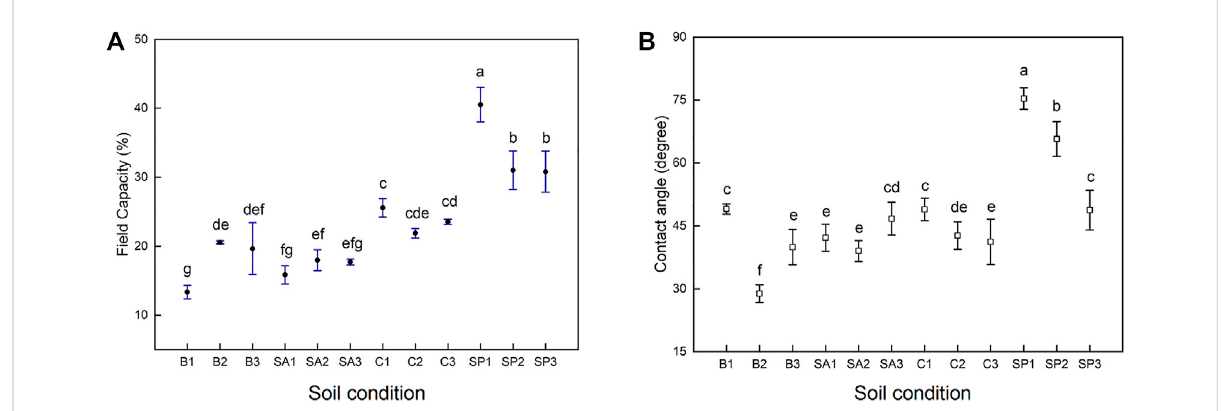
FIGURE 3 The fi eld capacity (A) and contact angle (B) of the soils under different vegetation. The small letters denote the signi fi cance ( p < 0.05).